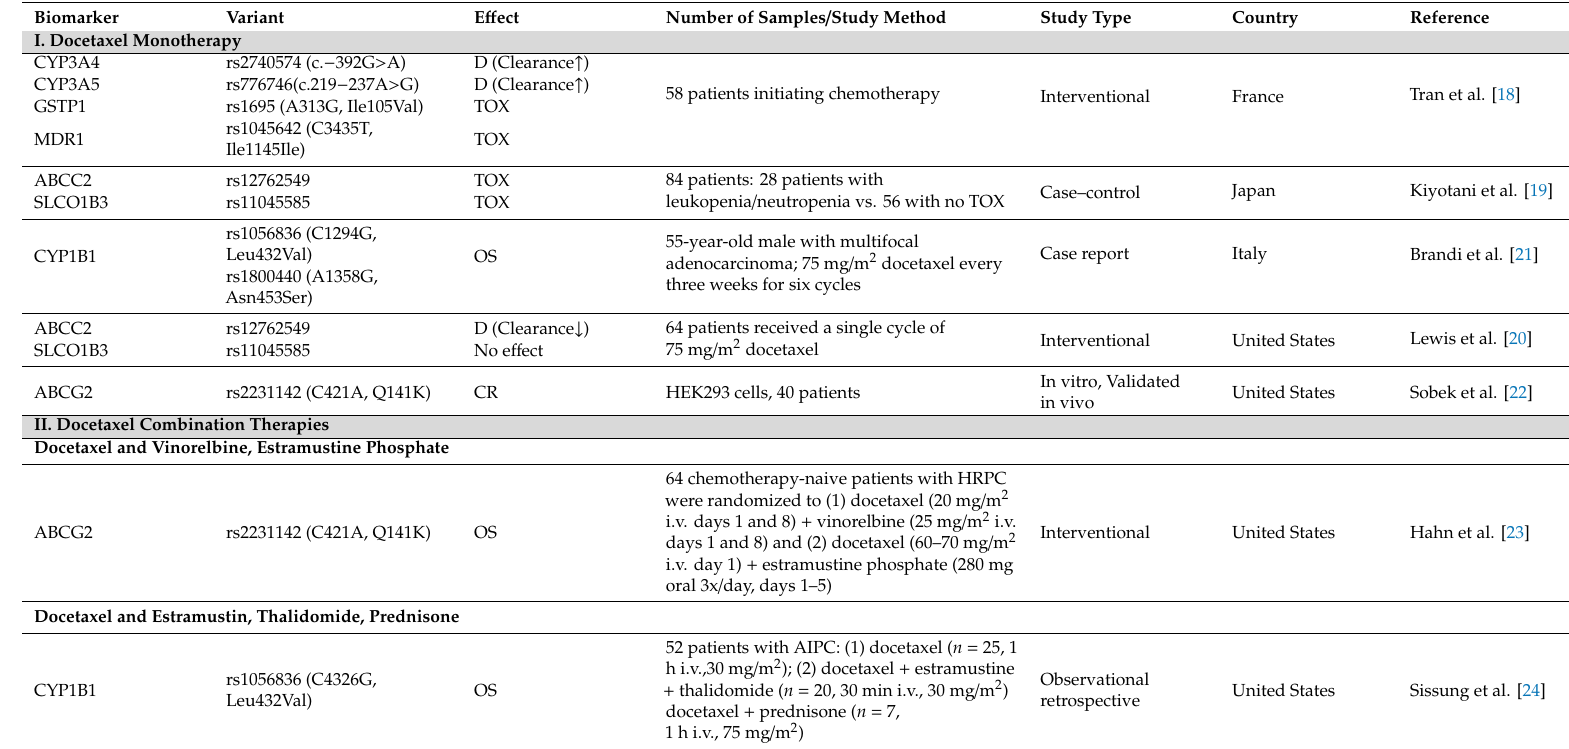
Table 1. Research studies of germline biomarkers in docetaxel and combination treatment of prostate